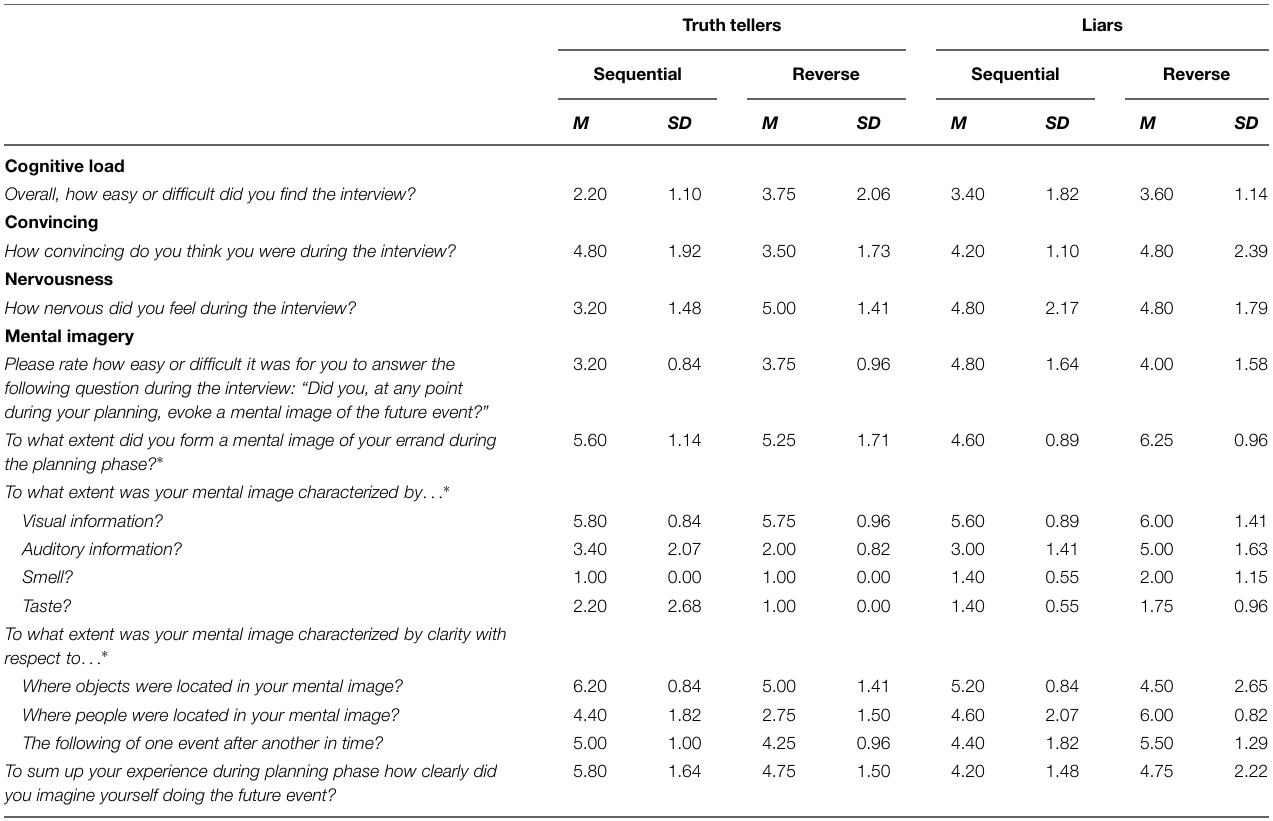
TABLE 2 | Ratings of subjective experience of psychological